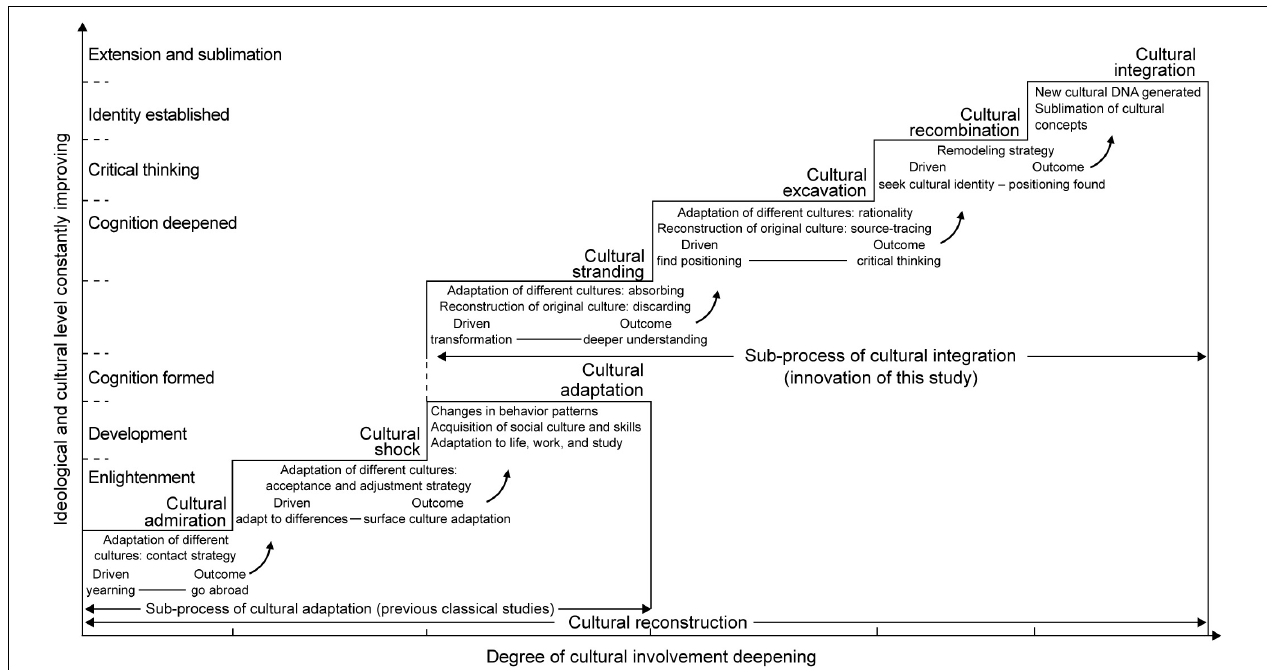
FIGURE 1 | Ladder model of deep cross-cultural reconstruction process among art